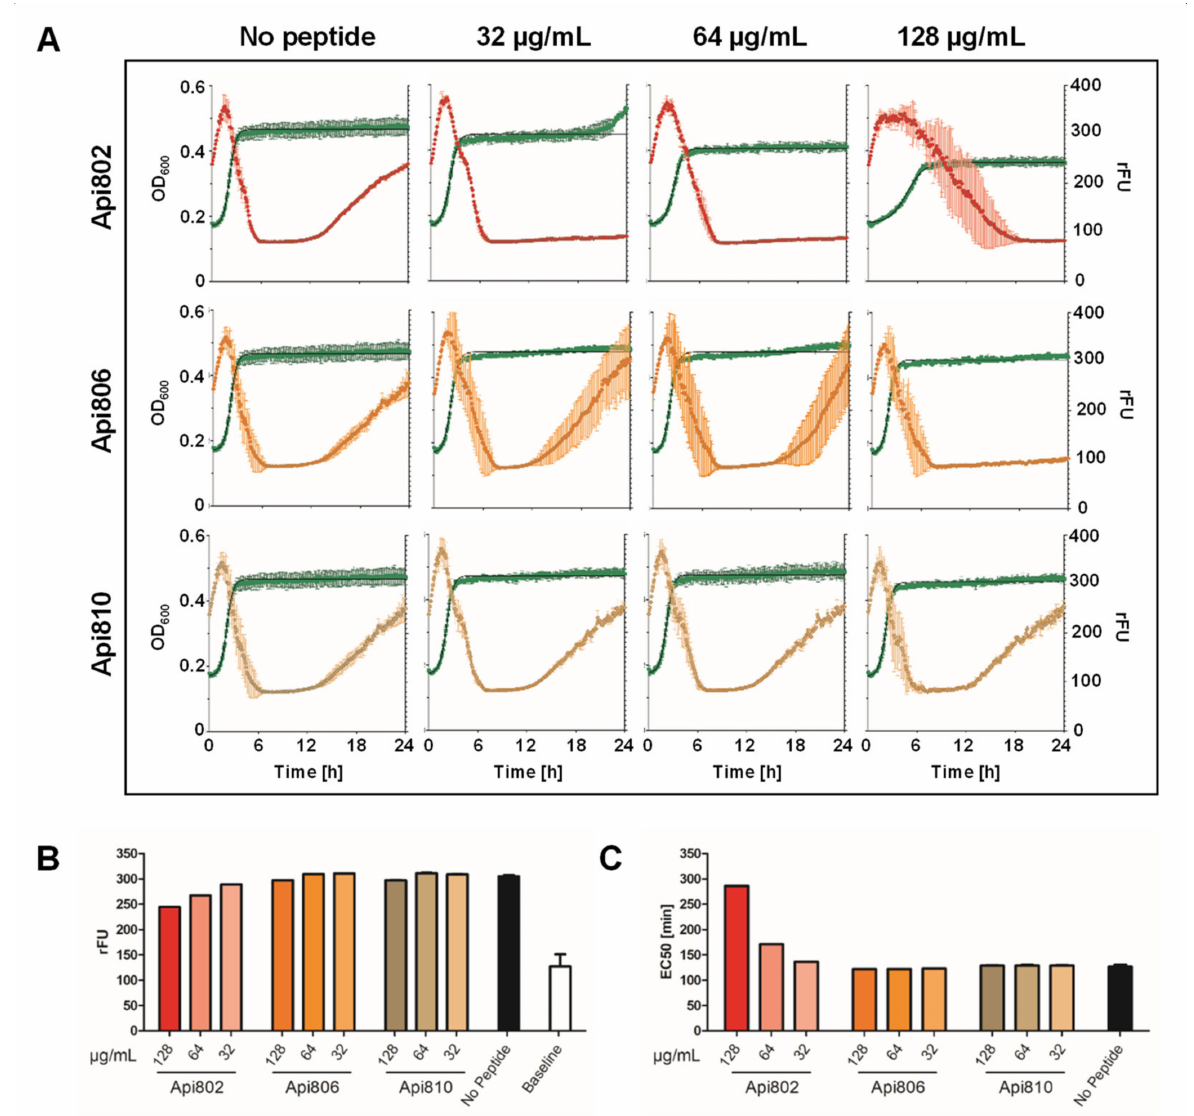
Figure 4. Influence of Api802, Api806, and Api810 on phage-mediated expression of sfGFP in E. coli Rosetta pLysS infected with T7Select-sfGFP phage (MOI 0.0625). ( A ) OD 600 and relative sfGFP fluorescence intensities (green curve) of E. coli cultures incubated with Api802 (red), Api806 (orange), or Api810 (beige); ( B ) Maximal relative fluorescence intensities (rFU) and ( C ) EC 50 values observed for the datasets shown in panel A. ( A – C ) Experiments were completed twice in triplicates. Error bars show the standard deviation of all three replicates of one representative